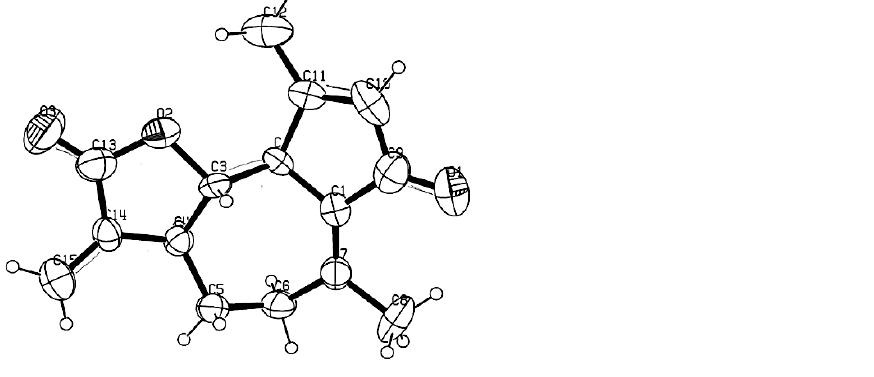
Figure 8. Computer-generated Oak Ridge Thermal Ellipsoid Plot (ORTEP) of dehydroleucodine ( 13 ) from X-ray diffraction analysis.